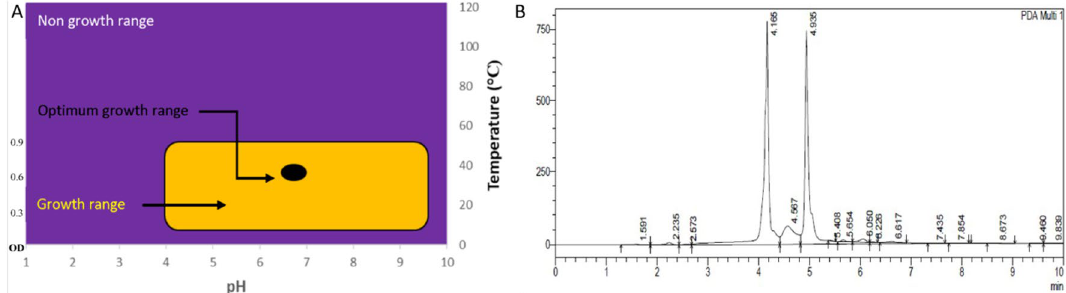
Figure 2. ( A ) The graphic diagram of the P. peoriae IBSD35 optimum growth curve in LB medium. The purple zone indicates the non-growth region, yellow zone represents the growth region, and the black dot indicates the optimum growth zone. (Left Y-axis is the optical density, Right Y- is the optimum temperature, and X-axis is the pH). ( B ) The chromatogram of the RP-HPLC. X-axis shows the retention time in min while Y-axis shows the absorbance. (The retention times indicate the peaks for practical purposes. 4.165 represents peak P4, and 4.567 represents peak P5). P4 retention time is 4.165 min. The P5 retention time is 4.567 min. Sharp peaks of P4